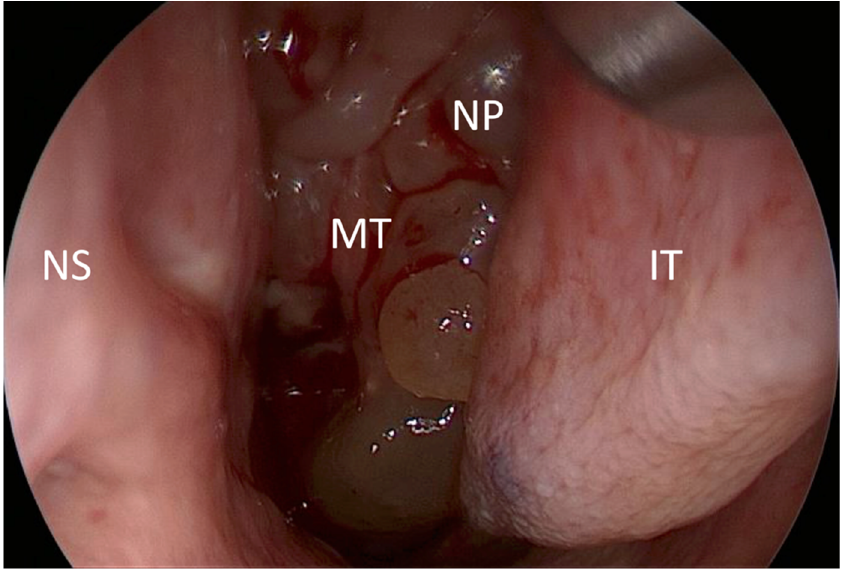
Figure 2. Intraoperative endoscopic view during paranasal sinus surgery in CRS. Nasal polyps (NP) embracing the middle turbinate (MT) and the inferior turbinate (IT) and reaching the nasal septum (NS).